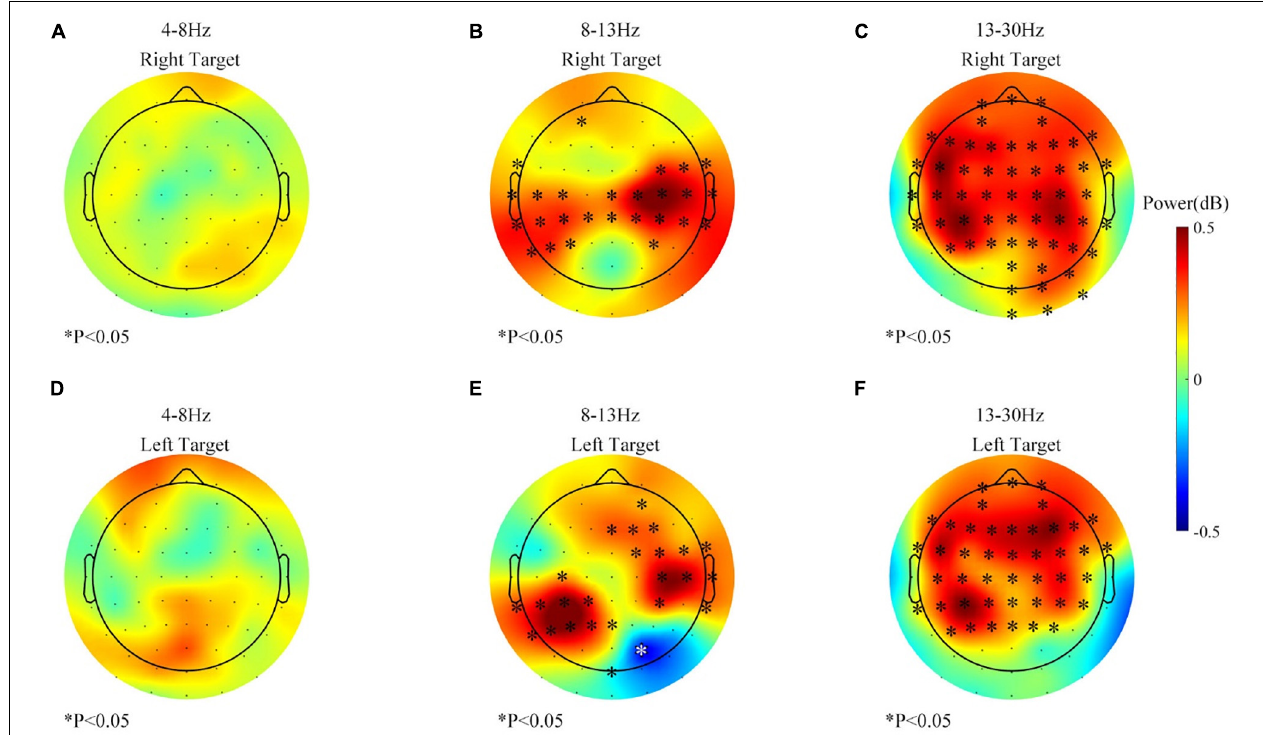
FIGURE 5 | The band power changes during 1–120 trials (61–120 vs. 1–60, feedback period) of all the sessions. (A) Theta (4–8 Hz) power change of the right target. (B) Alpha (8–13 Hz) power change of the right target. (C) Beta (13–30 Hz) power change of the right target. (D) Theta (4–8 Hz) power change of the left target. (E) Alpha (8–13 Hz) power change of the left target. (F) Beta (13–30 Hz) power change of the left target. ∗ p ≤ 0.05; both black and white stars were used for better